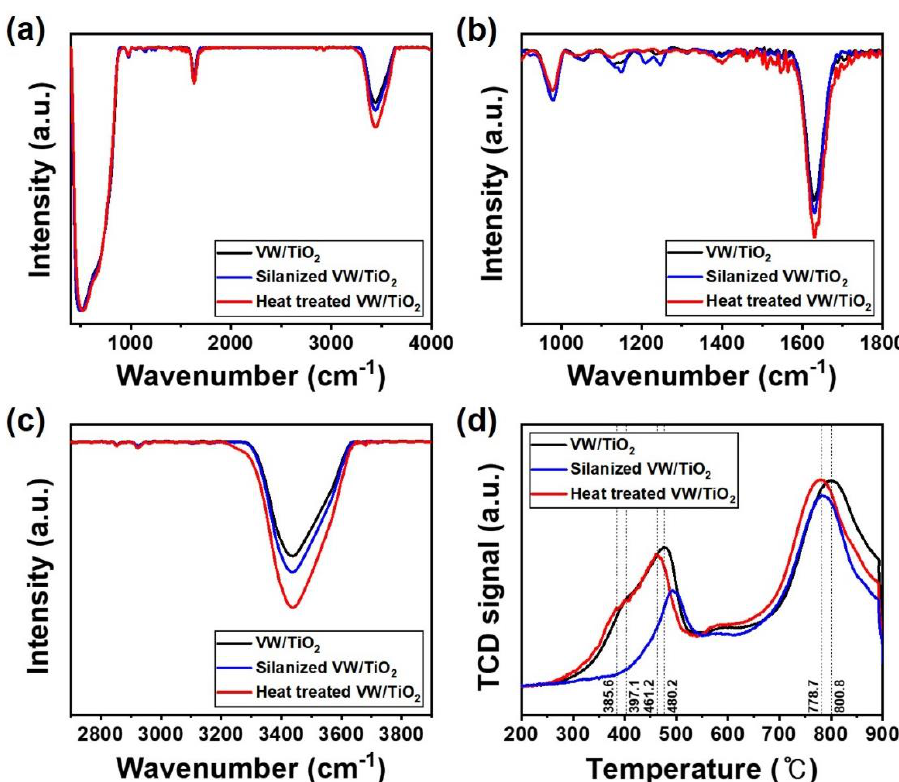
Figure 5. Fourier transform infrared spectra ( a – c ) and H 2 -temperature-programmed reduction ( d ) of V 2 O 5 -WO 3 /TiO 2 (black line), silanized V 2 O 5 -WO 3 /TiO 2 (blue line), and heat-treated V 2 O 5 -WO 3 /TiO 2 (red line).